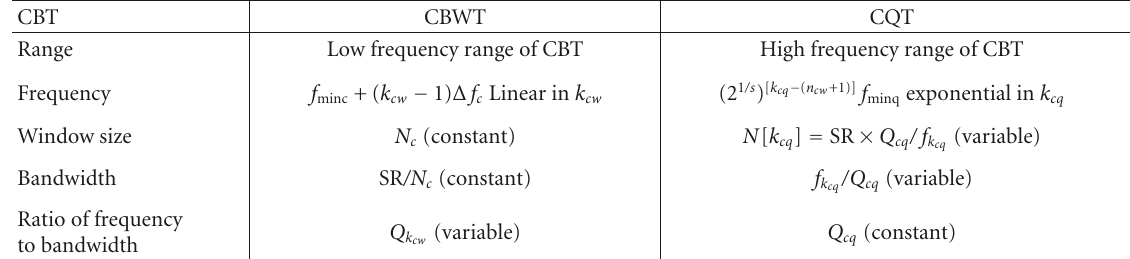
Table 1: Comparison of the parameters in CBWT and